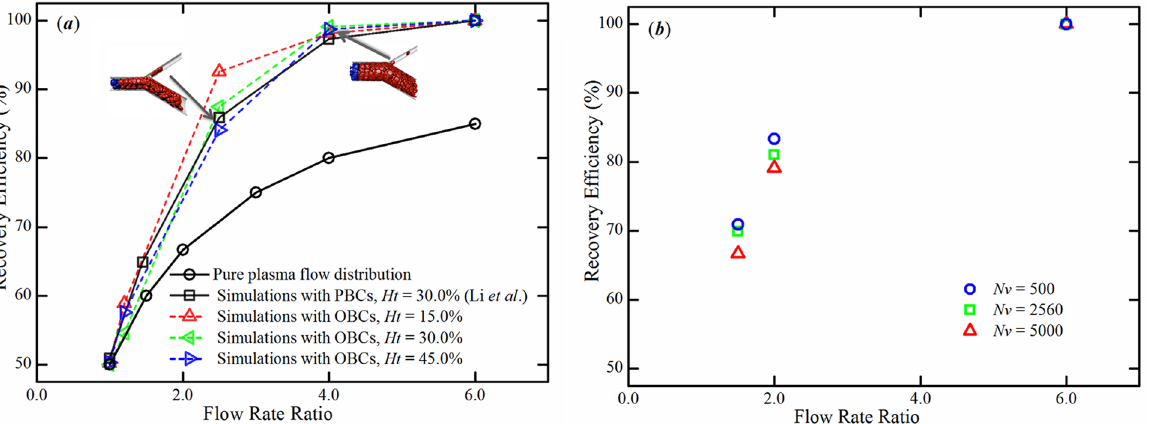
Fig 5. Particle recovery efficiency with respect to flow rate ratio. ( a ) Particle recovery efficiency at different hematocrit levels. Two snapshots of the RBCs at microvascular bifurcations with flow rate ratios of 2.5 and 4.0 at H t = 45.0% are shown. Simulation data (black squares) from [32] are shown. ( b ) Particle recovery efficiency at different levels of coarse-graining of the MS-RBC model at H t = 15.0%. The simulations are conducted using the MS-RBC model with N v = 500, 2560 and 5000.